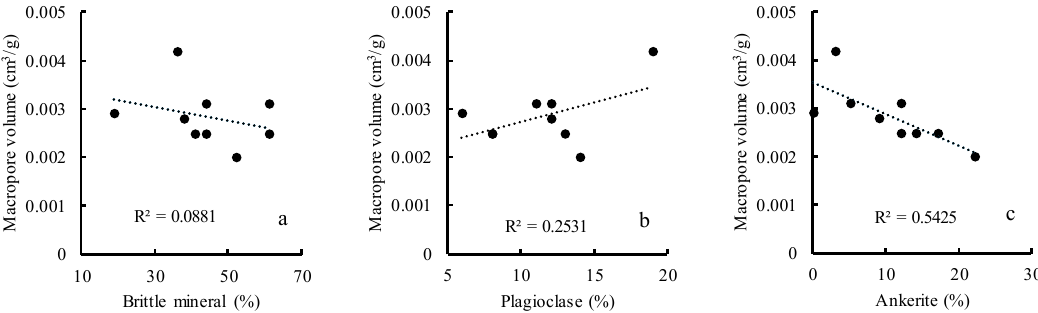
Figure 5. ( a ) The relationship between macropore volume and brittle minerals content. ( b ) The relationship between macropore volume and plagioclase content. ( c ) The relationship between macropore volume and ankerite content.